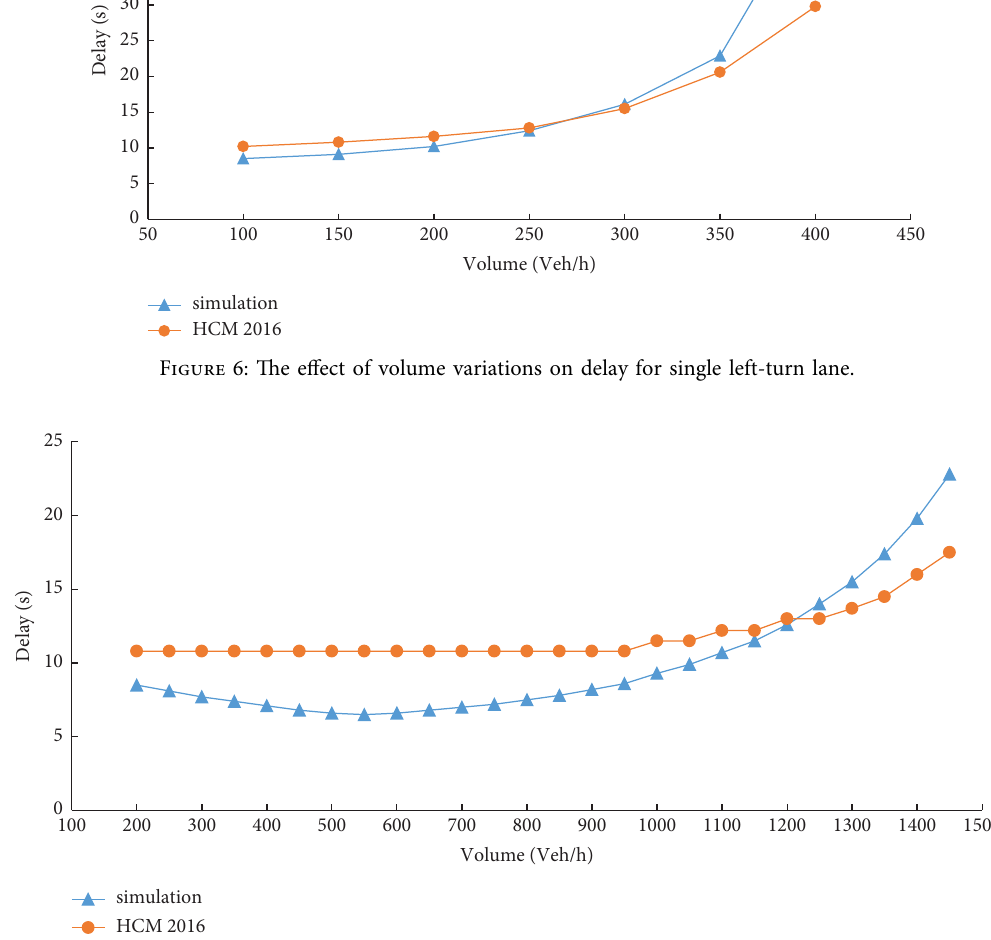
Figure 7: Te efect of volume variations on delay for dual right-turn lane. Table 4: F -test performed between simulation and HCM2016.